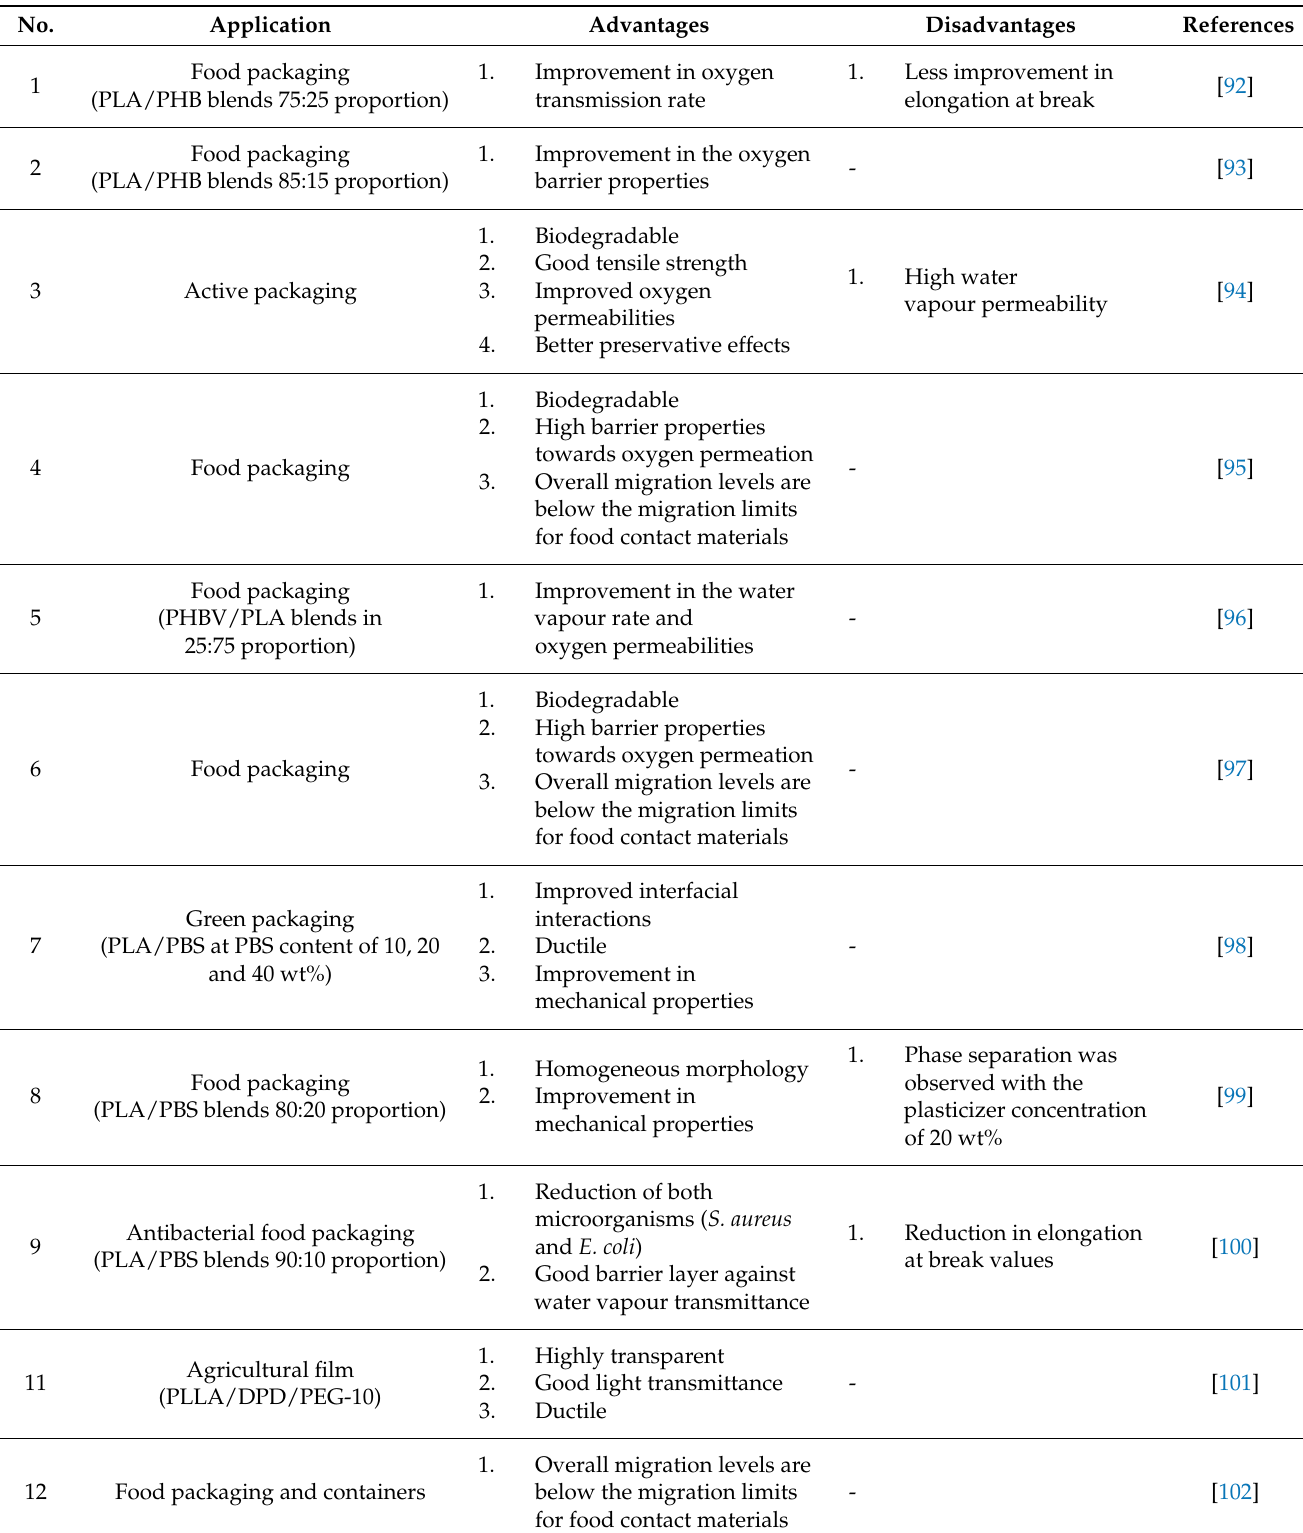
Table 3. Summarization of PLA-based